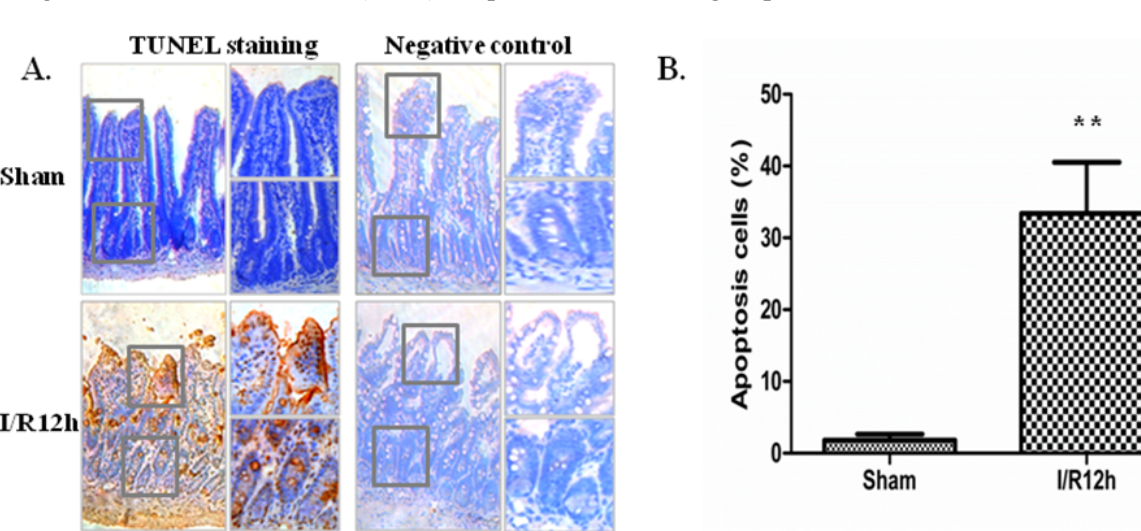
(12 h). ( A ) TUNEL-positive cells (brown staining with diaminobenzidine) tended to be observed in the intestinal epithelial cells (original magnification ×200). Magnified view of the squared area is shown in the right side of the original picture (original magnification ×400); ( B ) Graphic representation of relative number of TUNEL-positive cells. Data are given as the means ± SDs ( n = 7). ** p < 0.01 vs. sham